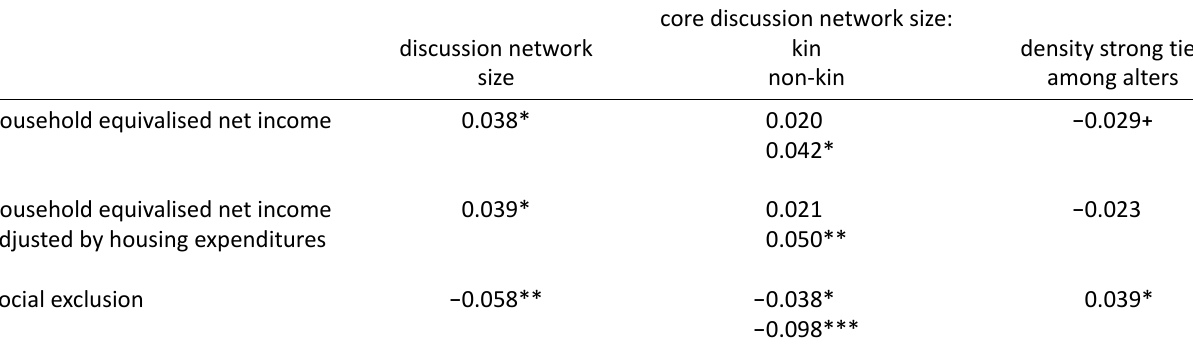
Table 1. Linear regression beta coefficients for household equivalised net income , household equivalised net income adjusted by housing expenditures , and social exclusion